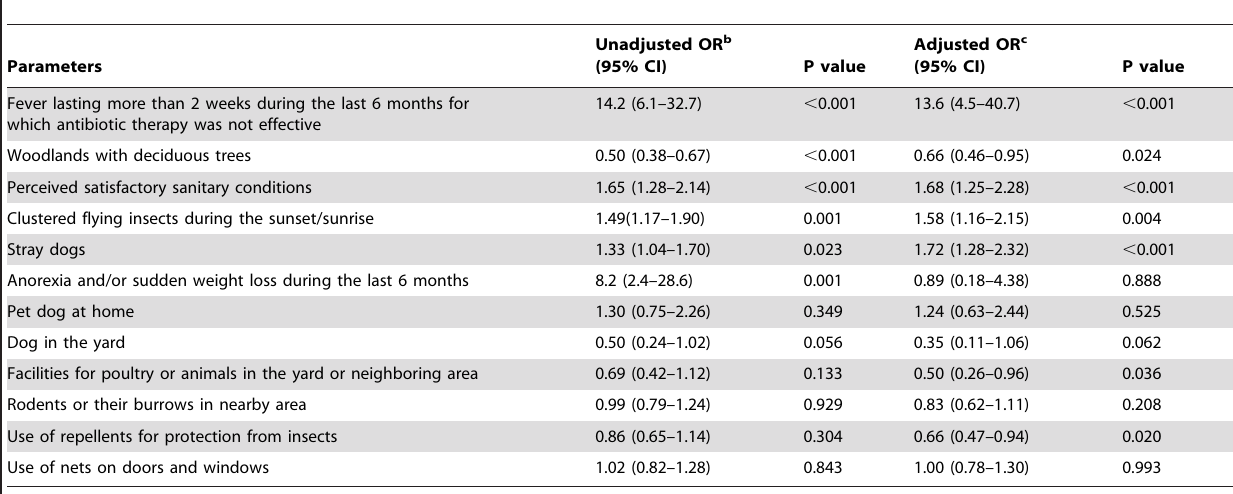
Table 2. Odds ratios from unadjusted and adjusted cumulative logistic models a predicting seropositivity of children at follow-up.